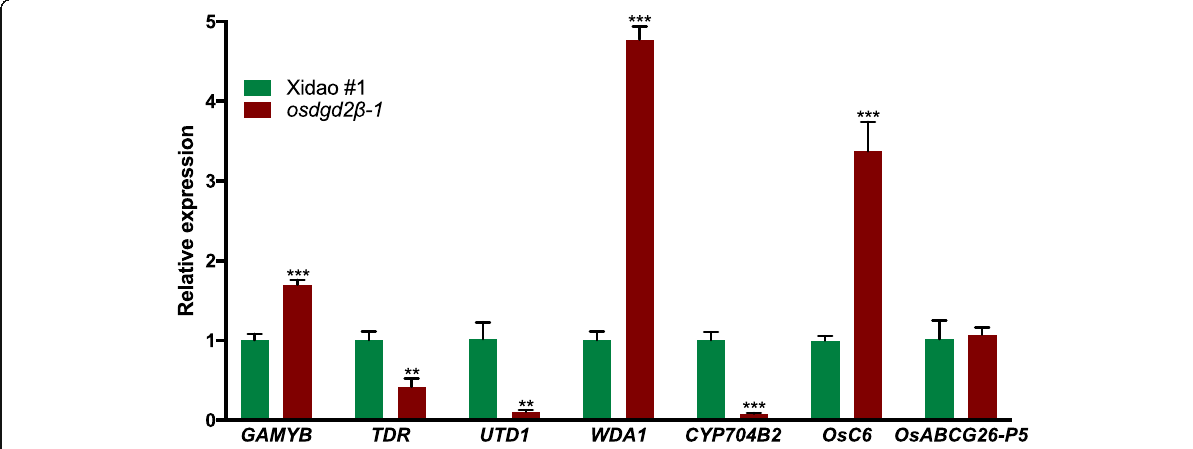
Fig. 7 Relative expression level of genes involved in anther development of a wild-type cultivar Xidao #1 and its mutant osdgd2 β -1 . The expression levels were normalized to the internal control gene OsACTIN . All values represent means ± standard deviations. Asterisk represent statistically significant differences (Tukey ’ s test, * P <0.05, ** P <0.01, *** P